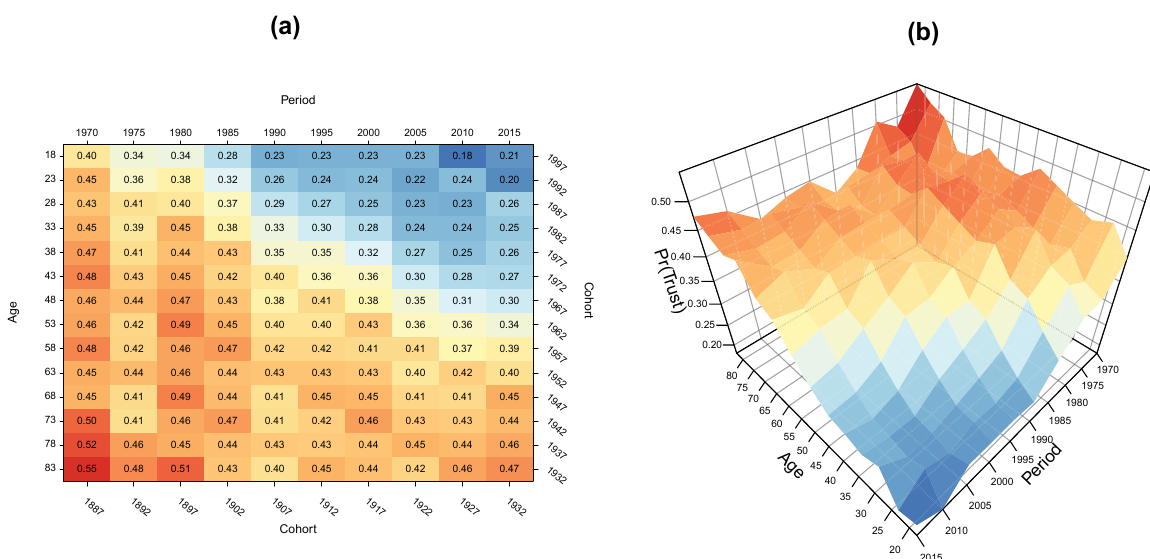
Figure 9: Two- and three-dimensional cohort–period Lexis surfaces. Notes: (a) and (b) display two-dimensional and three-dimensional Lexis surfaces, respectively, of predicted probabilities of the outcome for all observed combinations of cohort and period after adjusting for age. Calculations are based on θ 2 ( k − k ∗ ) + for all observed combinations of k = 1, . . . , K and j = 1, . . . , J . All estimates are derived from a diachronic L-APC logistic regression model. Outcome is social trust, coded so that 1 = “can trust” while 0 = “can’t be too careful” or “depends.” Results adjusted using sampling